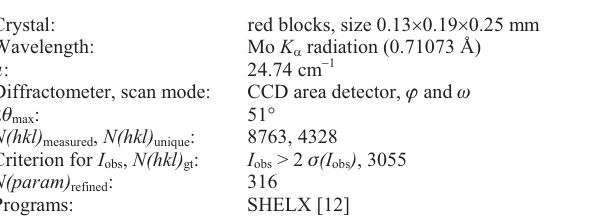
Table 1. Data collection and handling.